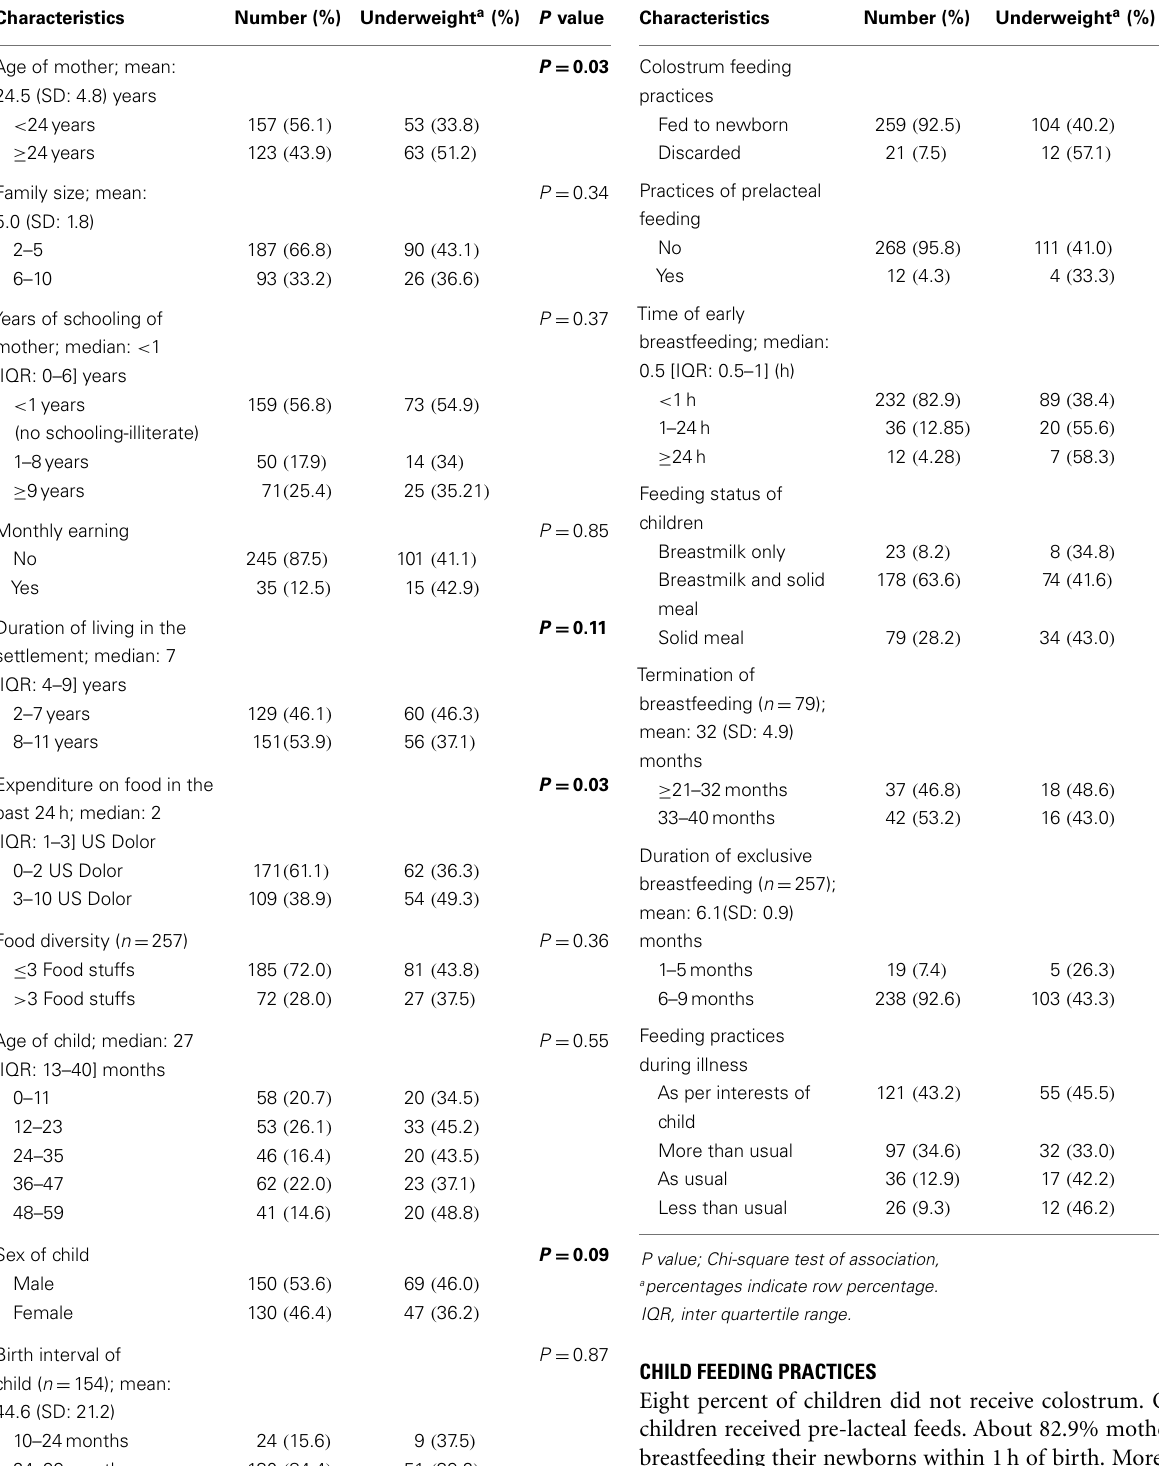
Table 1 | Characteristics of respondent mothers ( n = 280) . Table 2 | Child feeding practices ( n = 280)